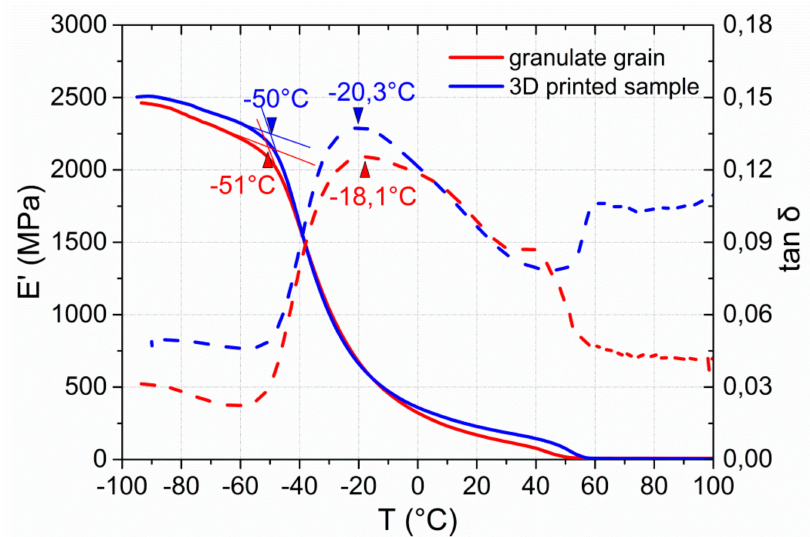
Figure 7. Thermal and mechanical properties of PEU as determined by DMA: Evolution of storage modulus E ’ (solid line) and tan δ (dashed line) at the second heating of a granulate grain (red color) and the sample of the substrate of a type 2 QR code carrier as manufactured via FFF (blue color).